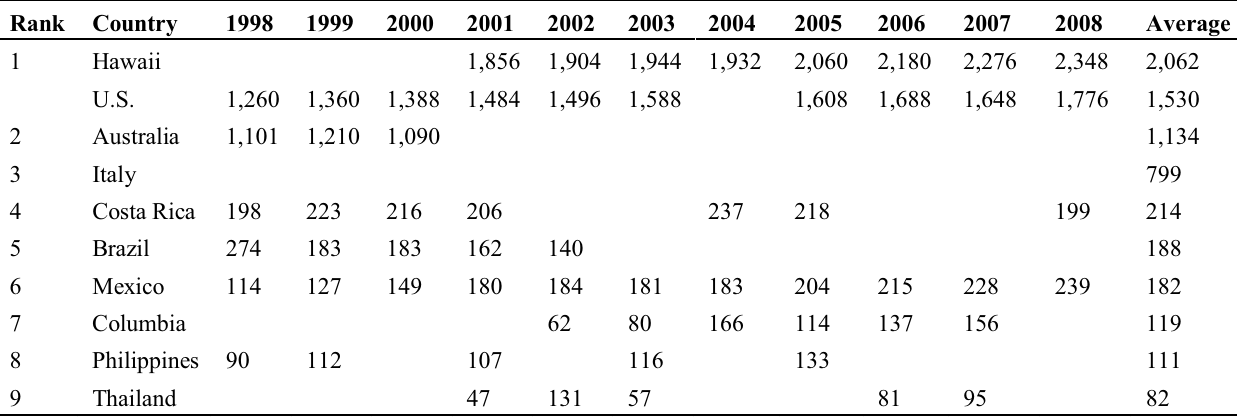
Table 2. High cost of farm wages in Hawaii compared to other regions monthly wage in U.S. dollars. Reprinted with permission from